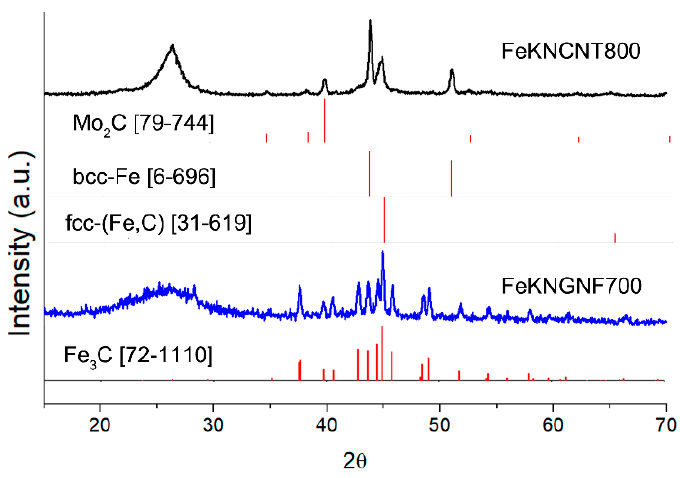
Figure 2. XRD pattern of fresh FeKNGNF700 and FeKNCNT800 catalysts.